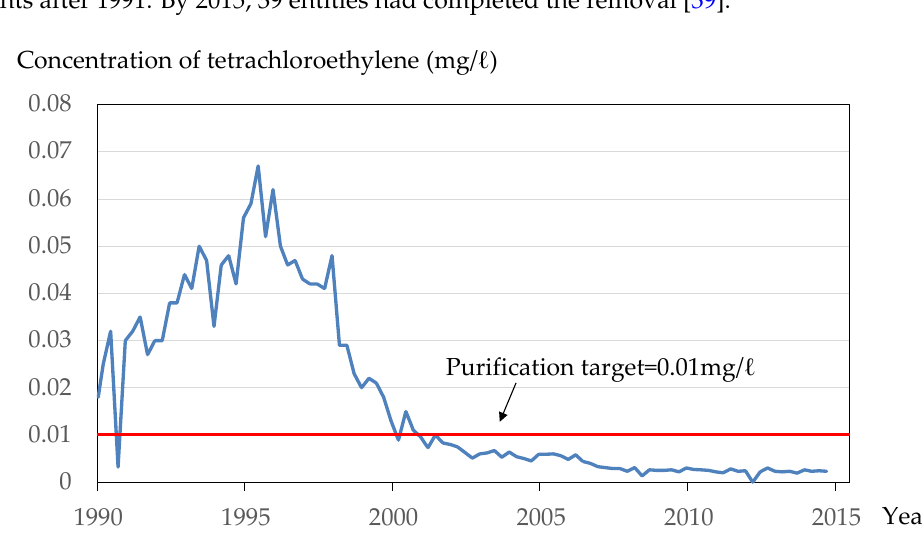
Figure 3. Change in tetrachloroethylene concentrations at the Kobo spring.